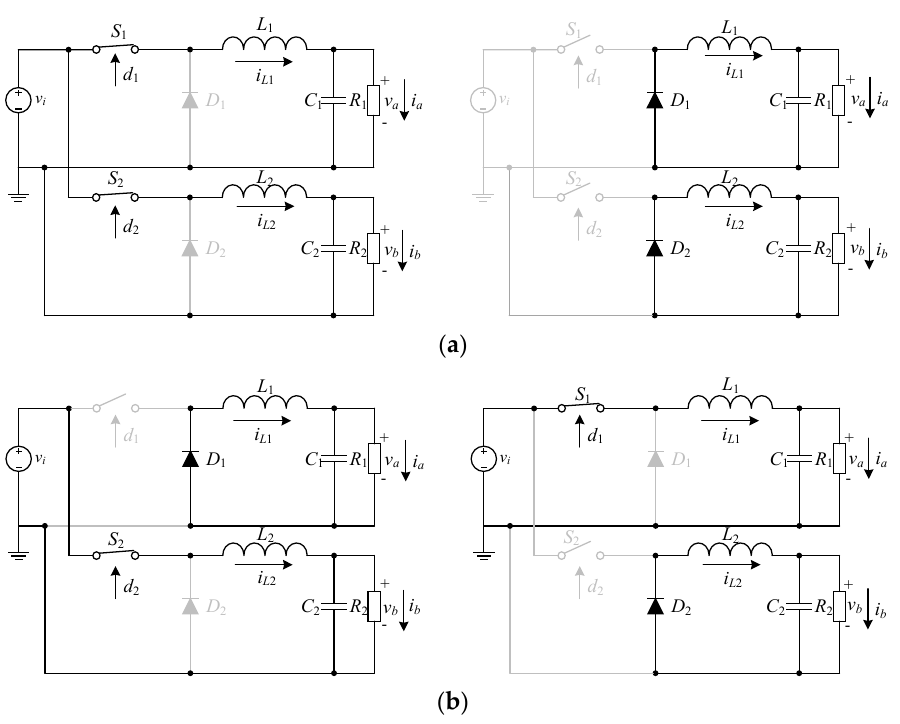
Figure 6. Switch status of S 1 and S 2 in DC mode. ( a ) i a = i b , S 1 and S 2 are switched on at the same time, ( b ) i a ≠ i b , S 1 and S 2 are switched o ff at the same time.